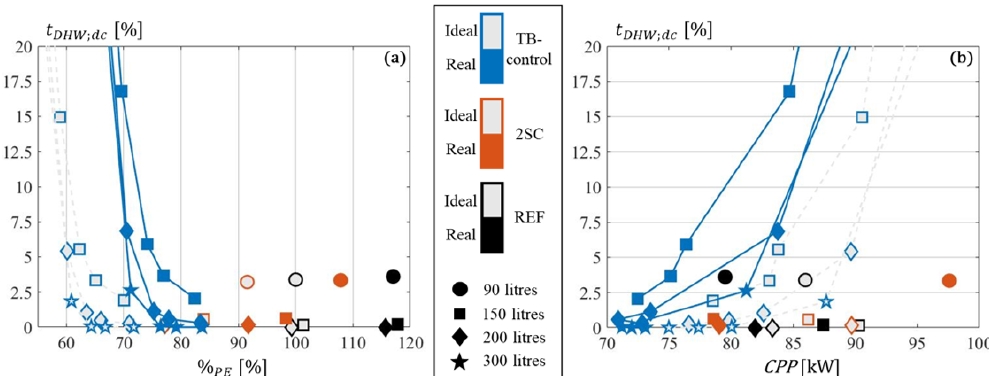
Figure 12. Results for considering a non-idealised central energy system. Graph ( a ) shows the results for t DHW ; dc and % PE , and ( b ) for t DHW ; dc and CPP. The shape refers to the DHW vessel volume and the colour (black, red, or blue) to the control strategy. An outlined data point is for an ideal central energy system, the other ones are for non-idealised central energy